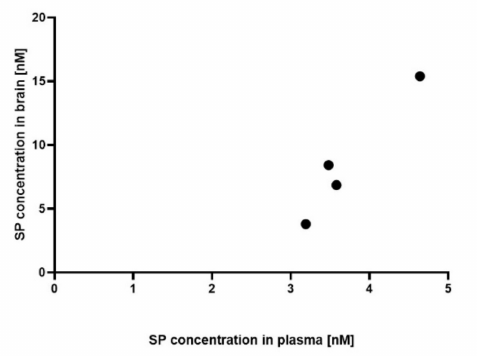
Figure 1. Association between plasma and brain SP600125 (SP) concentration. SP concentration was measured both in the plasma and in the brain of SP 30 mg / kg / day-treated acute myelin oligodendrocyte glycoprotein (MOG 35-55 ) experimental autoimmune encephalomyelitis (EAE)-diseased mice ( n = 4). n = 2 pairs had no detectable values in brain or plasma samples and were excluded. Mass spectrometry. Abbreviations: SP: SP600125. Statistic: Pearson r correlation, coe ffi cient 0.97, 95% CI: 0.19-1.0 and p <